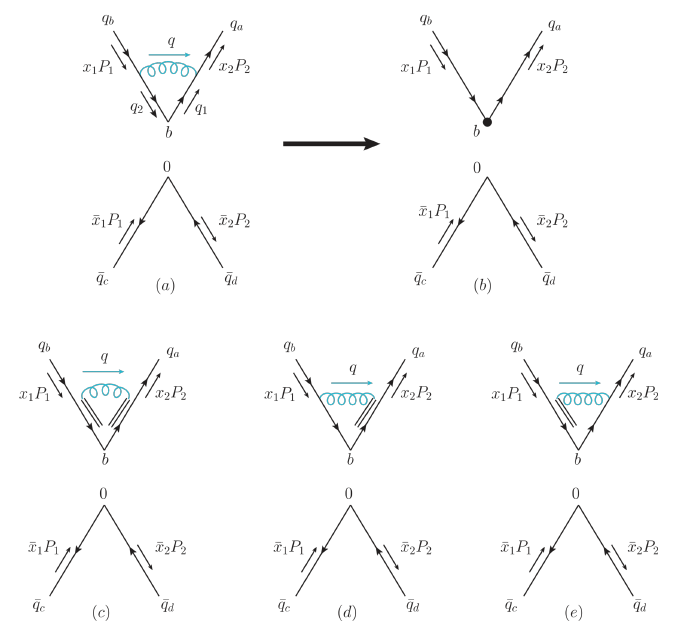
Figure 8 . Factorization of the form factor shown in figure 5(e). The panel (b) denotes the hard kernel function due to the exchange of a hard gluon, which corresponds to a vertex correction to the vector current or scalar density